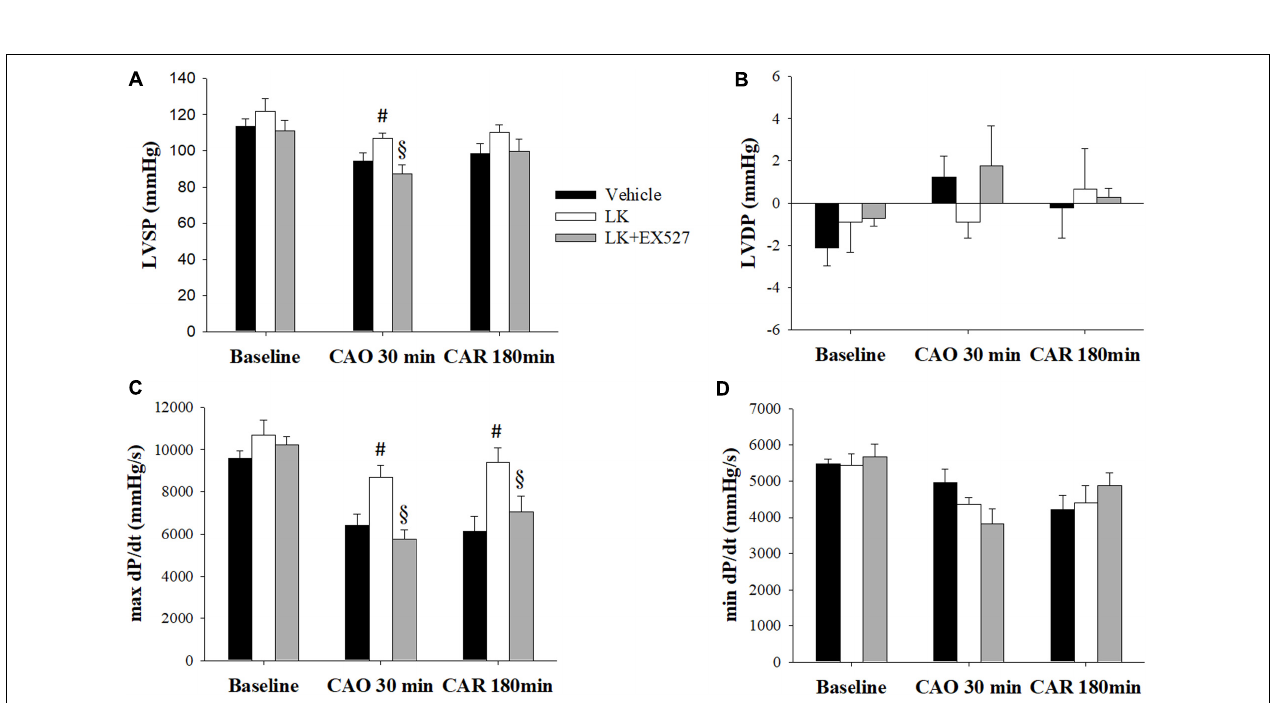
FIGURE 7 | Post-ischemic lumbrokinase treatment reserved myocardial ischemia-reperfusion injury induced cardiac dysfunction via Sirt1 activation. Post-ischemic treatment with vehicle or lumbrokinase (10 µ g/kg) was given 20 min after coronal artery ligation; the Sirt1 specific inhibitor, EX527, was administered 15 min after coronal artery ligation. Cardiac function parameters were assessed by a pressure transducer catheter inserted into the LV via the carotid artery. (A) LVSP, (B) LVDP, (C) max dP/dt, and (D) min dP/dt were determined before CAO (baseline), 30 min after CAO (CAO 30 min), and 180 min after reperfusion (CAR 180 min). Each value is represented as the mean ± SEM ( n = 4–10). # p < 0.05 compared with the vehicle group; § p < 0.05 compared with the LK group.